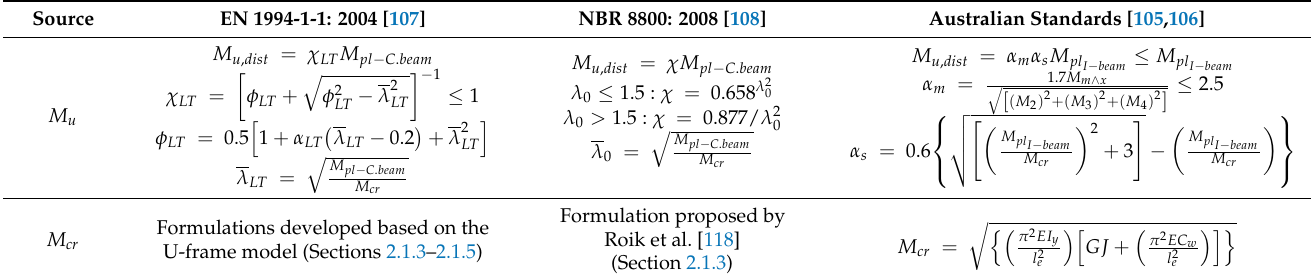
Table 8. Procedures for determining the LDB strength in SCCB. Adapted from Rossi et al.